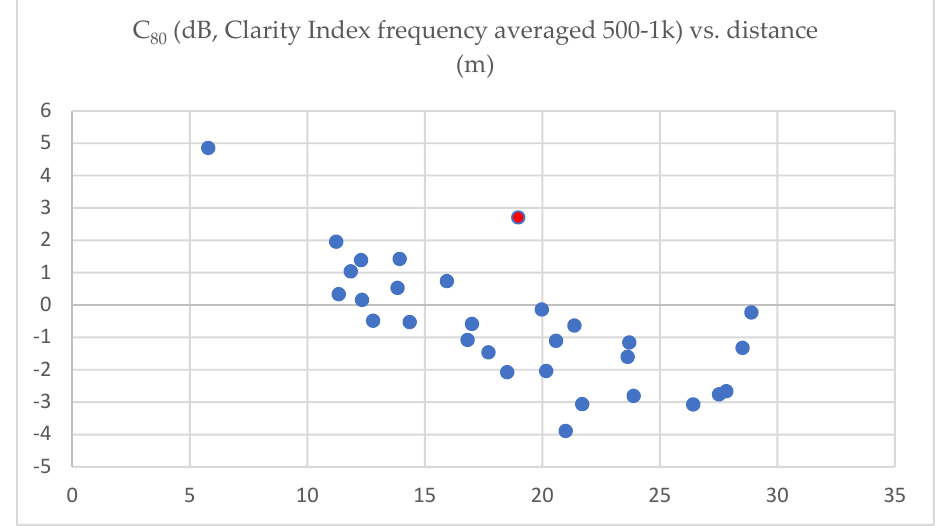
Figure 9. Clarity index (C 80 ) vs. source–receiver distance (m).